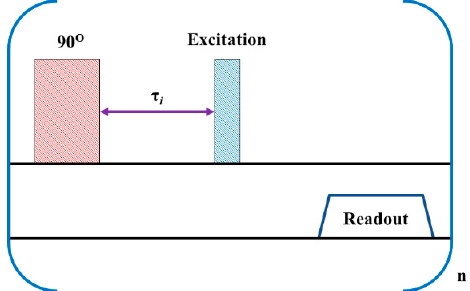
Figure 1. 129 Xe time-of-flight (TOF) perfusion imaging pulse sequence diagram. The 90° pulse with narrow bandwidth (in pink) is applied first. After the recovery time delay, τ (the purple arrow), the imaging pulse sequence is initiated. The excitation pulse is represented by the blue rectangle. This pulse sequence is repeated n times. Index i corresponds to the delay time with an index number i.